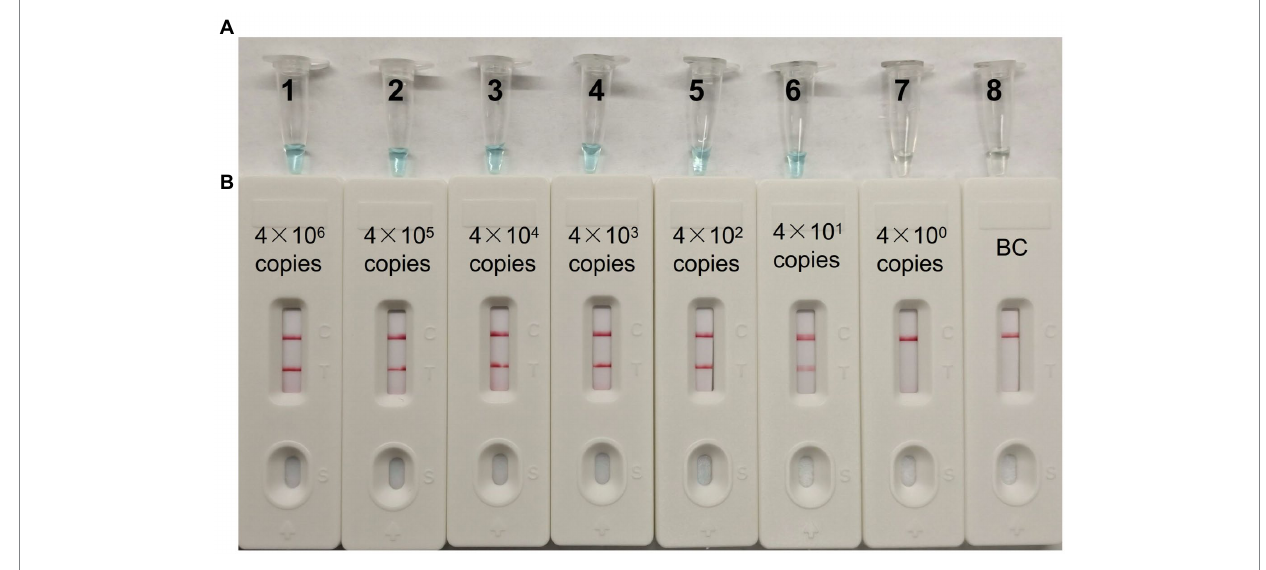
FIGURE 4 The detection limit of CVA16-MCDA-LFB assays. Two measurement techniques, including (A) a colorimetric indicator (VDR) and (B) lateral flow biosensor. A series of dilutions (4 × 10 6 –4 × 10 0 copies) of pUC57-CVA16-VP1 DNA and a blank control (BC) double-distilled water were operated according to standard MCDA-LFB reactions.